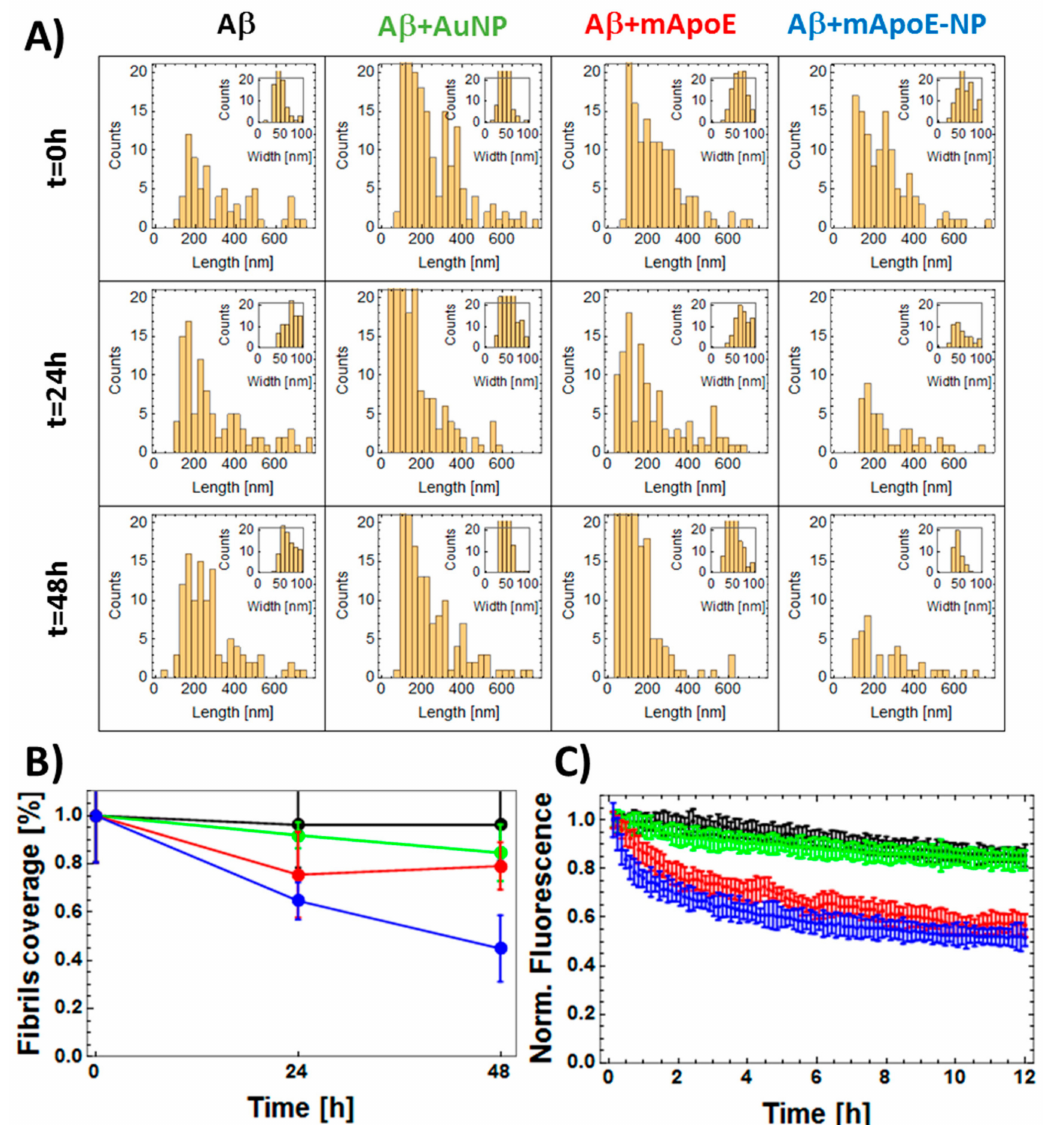
Figure 6. Quantitative analysis of the e ff ect of external chemical agents on the disaggregation of preformed A β fibrils. ( A ) Statistical analysis of fibrils length (main figures) and width (insets) as obtained from the AFM data reported in Figure 5B. Similar to Figure 5B, data obtained following treatment as indicated by the top labels (bare A β 1-42, A β in the presence of bare AuNP, free mApoE, or AuNP coated with mApoE) and left labels reporting the di ff erent incubation times ( t = 0 h, t = 24 h, t = 48 h). ( B ) Quantitative analysis of AFM images reported in panel A. Normalized value of percentage of deposited fibrils plotted as a function of time of disaggregation. Data obtained for A β bare in solution (black dots) and in the presence of bare AuNP (green dots), free mApoE (red dots), AuNPs coated with mApoE (blue dots). The reported coverage value of deposited fibrils is normalized with respect to the average initial value ( t = 0). ( C ) ThT assay-based evaluation of the evolution of preformed fibrils. THT fluorescence plotted as a function of time in 2 µ M concentrated pre-fibrillated samples of A β stained with 10 mM THT: free A β (black squares) is compared to A β added with bare AuNP (green circles), free mApoE (red diamonds), or AuNPs coated with mApoE (blue stars). The normalized fluorescence values are obtained as F(t) / F(0), where F(t) and F(0) are the fluorescence values measured at time t and 0. The normalized fluorescence values are the average of three repetitions. Error bars represent standard